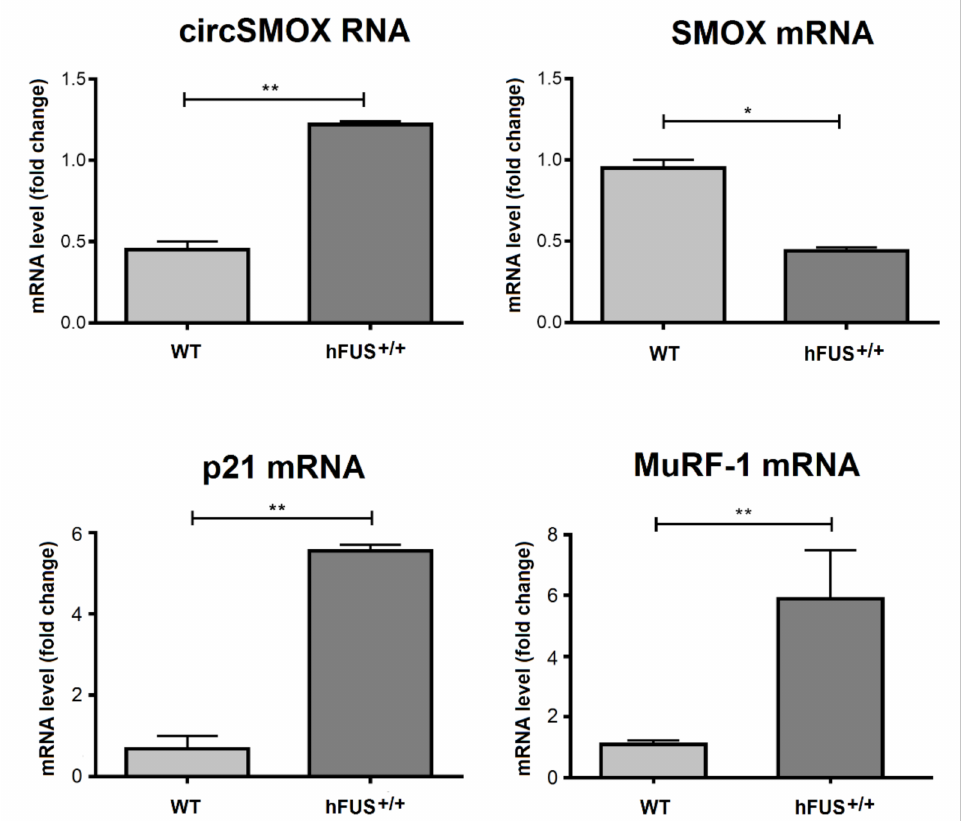
Figure 9. Linear and circular SMOX RNA expression in hFUS +/+ mice. qRT-PCR of linear SMOX, circSMOX RNA, p21 and MuRF-1 RNA transcripts amplified from gastrocnemius of symptomatic 38 days old hFUS +/+ mice (TG) and their control littermates (WT). Data are calculated relative to the internal housekeeping gene (GAPDH) and are expressed as the mean fold change compared with WT controls. Each value represents the mean ± SD of three independent experiments. Student’s t test was used to determine significant di ff erences * p < 0.05, ** p < 0.01 compared to control